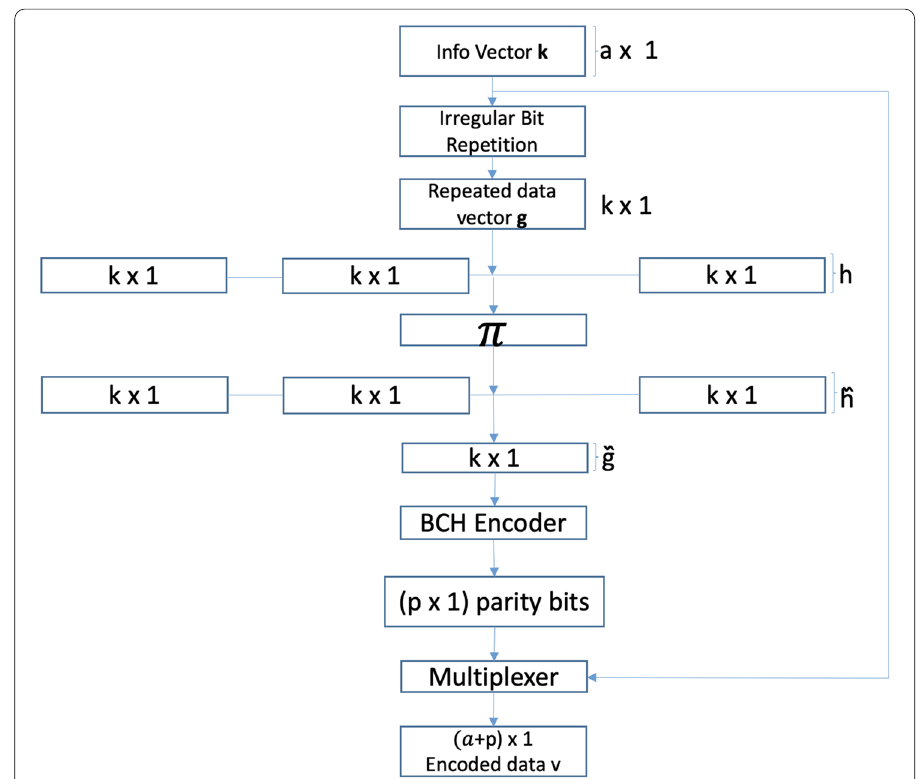
Fig. 1 Encoding structure of the irregular Vector Turbo